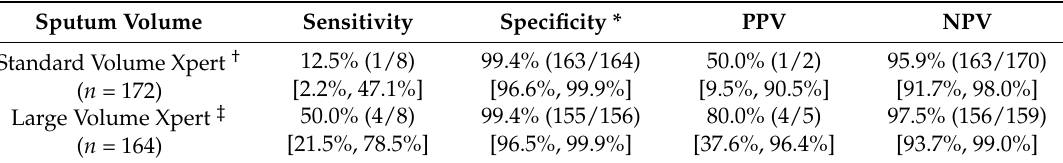
Table 1. Xpert Sensitivity and Specificity